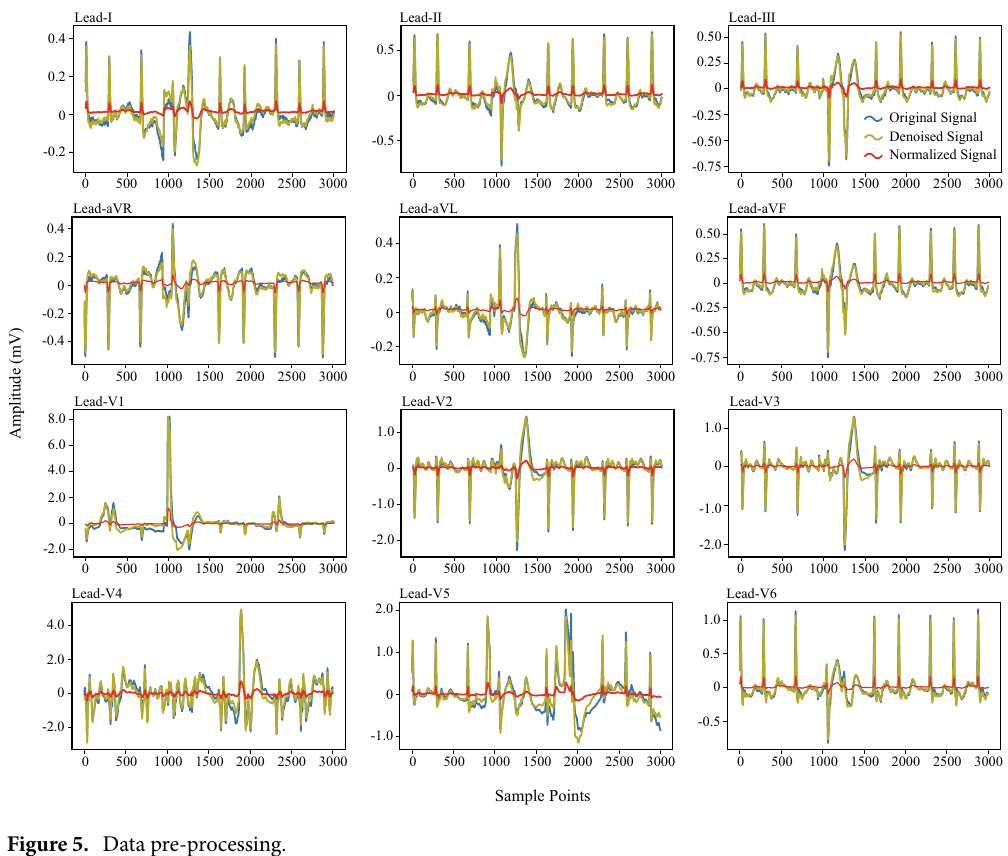
Figure 5. Data pre-processing.